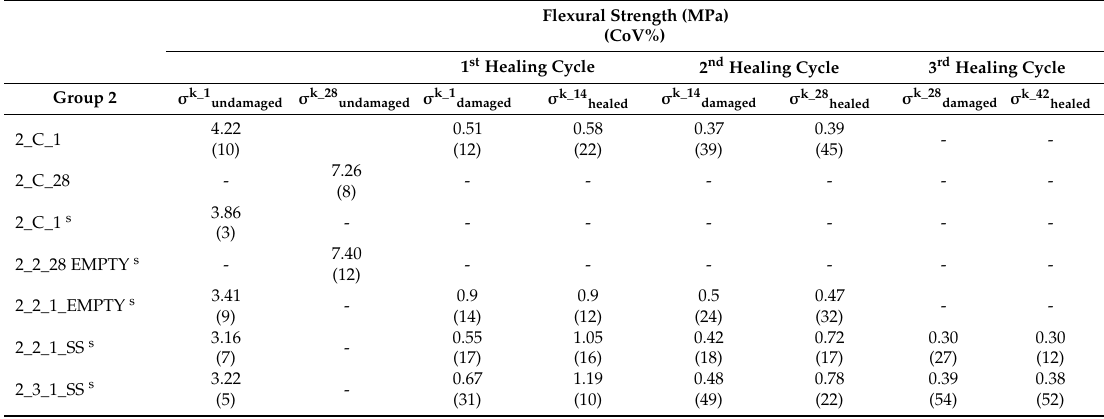
Table 4. Group 2: Flexural test results for three damage-healing cycles.